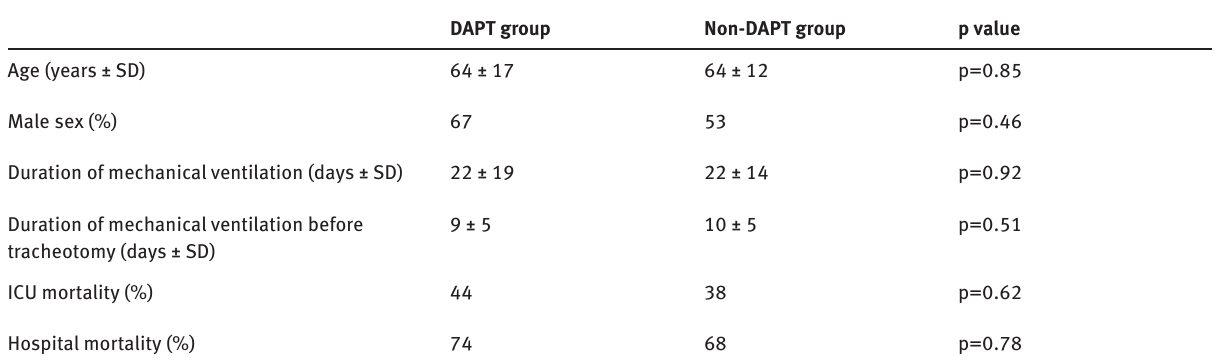
Table 3: Patient